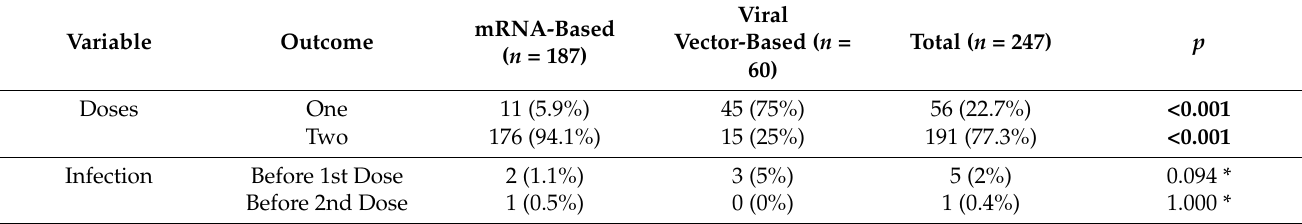
Table 3. COVID-19-related anamnesis of the surveyed Polish healthcare